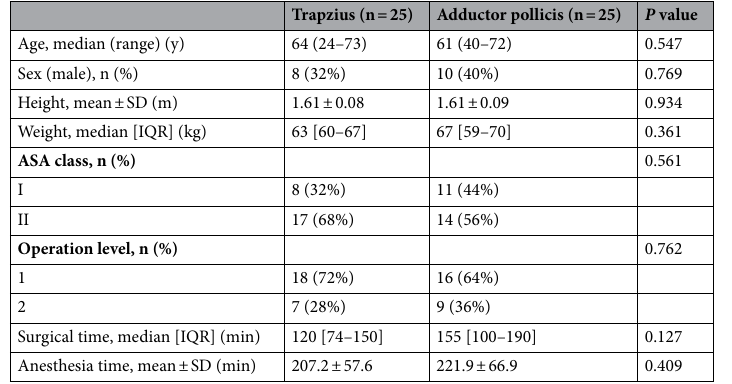
Table 1. Demographic and clinical characteristics of patients. ASA American Society of Anesthesiologists; SD standard deviation; IQR interquartile range.